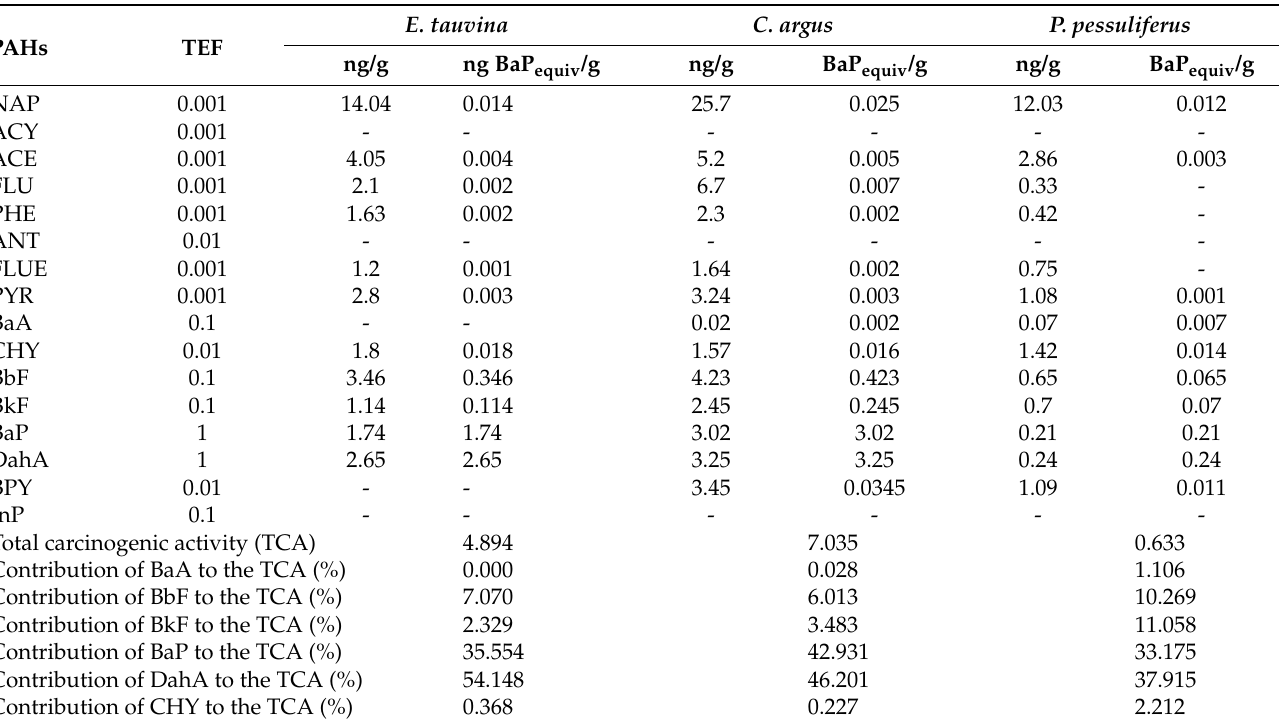
Table 10. B[a]P equivalent concentrations for PAH compounds in three endemic fishes.